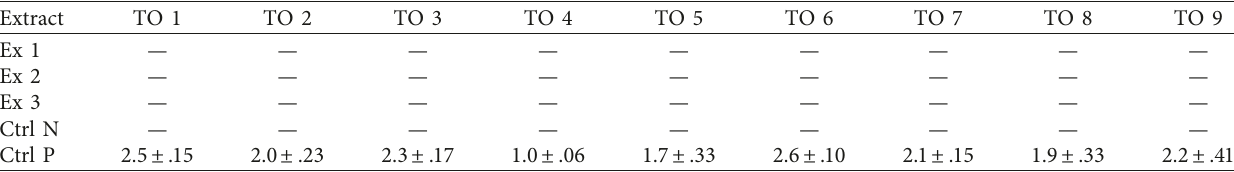
Table 4: Antimicrobial activity of fractions of ripe fruits against test organisms. Extract TO 1